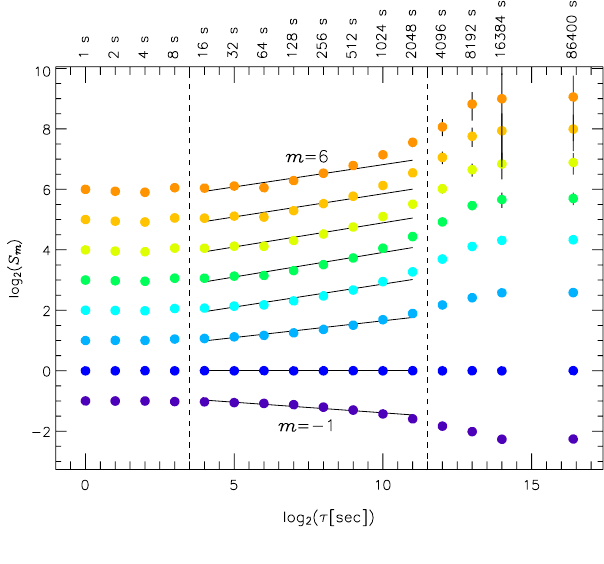
Fig. 9. A generalised structure function (GSF) analysis of the SWB fluctuations showing the variation of the moments S m ( τ) = h| δ v sw ( t, τ ) | m i with temporal scale τ for orders m = − 1 to 6. Weighted least squares fits have been applied to all the moments between τ =16 and 2048s to estimate the individual ζ ( m) . Error bars are drawn at the 3 σ level but are barely visible in the plot.